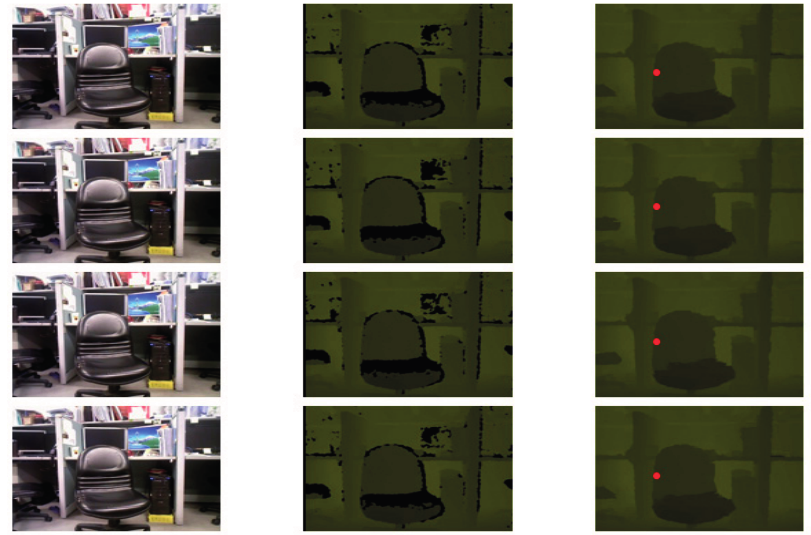
Figure 8. Temporally filtered images.